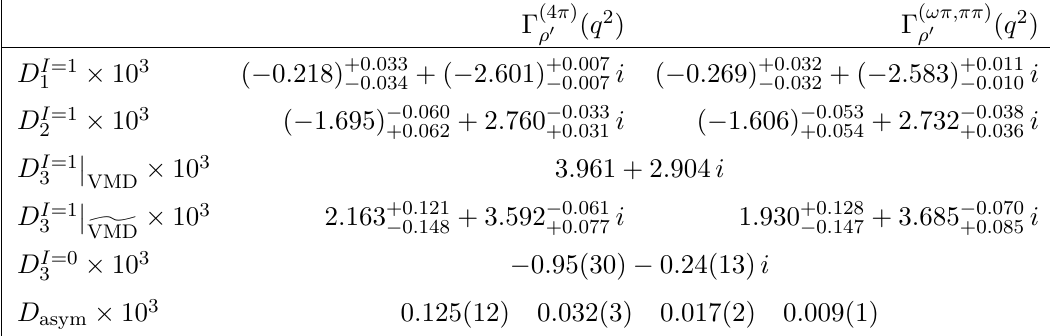
Table 6 . Coefficients from equation (5.12), based on table 5 and the normalizations from table 1. For the extended VMD version the result in general depends on the (cid:15) case for C a = 0 . For D I =0 the error is propagated from equation (3.27) and for D asym from 3 2 equation